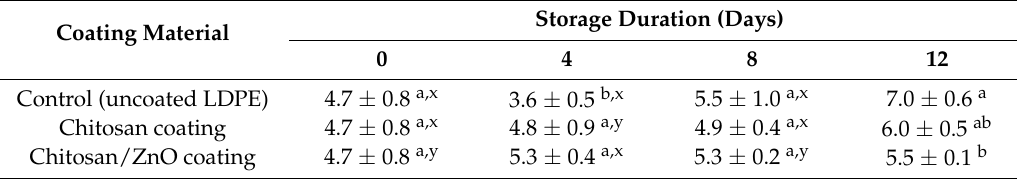
Table 2. Effect of different coatings on total soluble solids (brix) in okra samples during different storage periods.